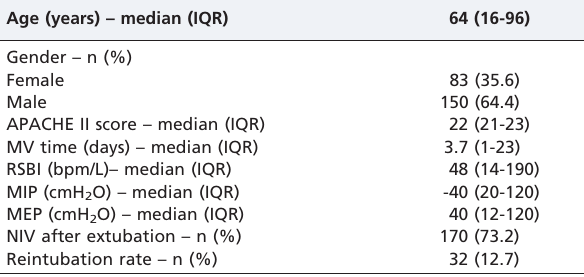
Table 1 - Characteristics of the 252 mechanically ventilated patients treated at Albert Einstein Jewish Hospital during a 15-month period.